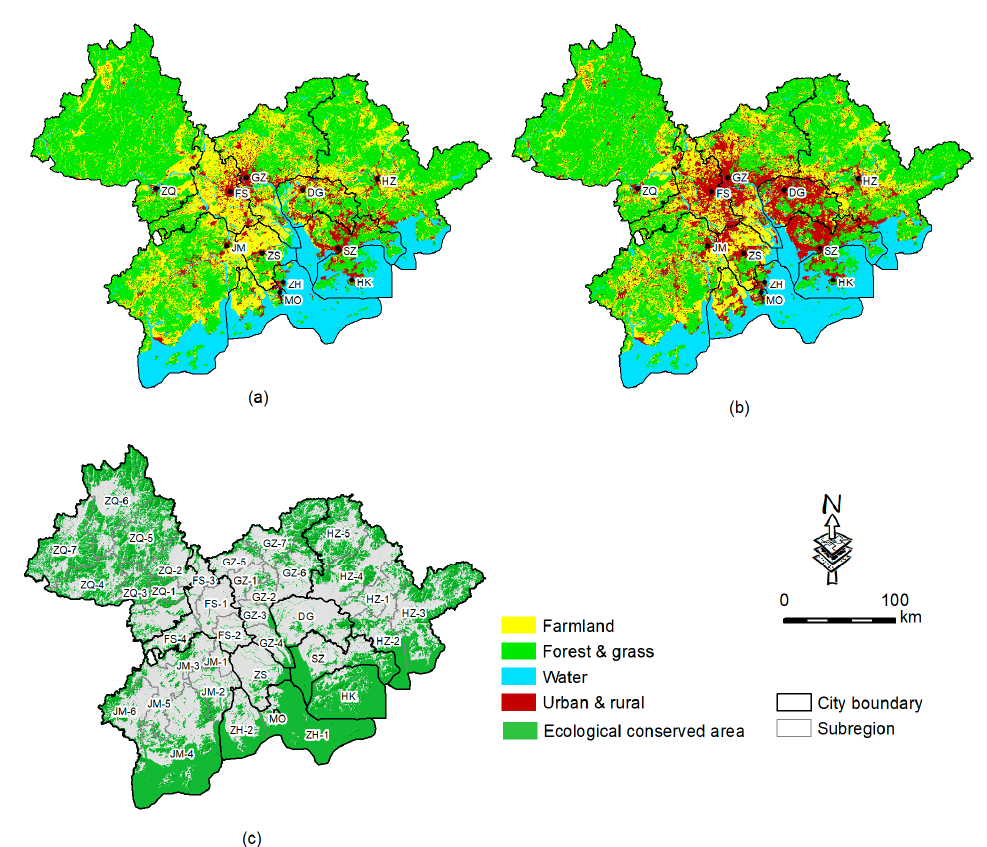
Figure 2. Primary data for simulation modeling ( a ) land use in 1995; ( b ) land use in 2015; ( c ) subregion division and ecological conservation area.